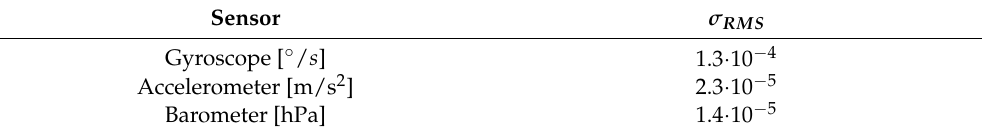
Table 3. Sensor bias specification ( w b